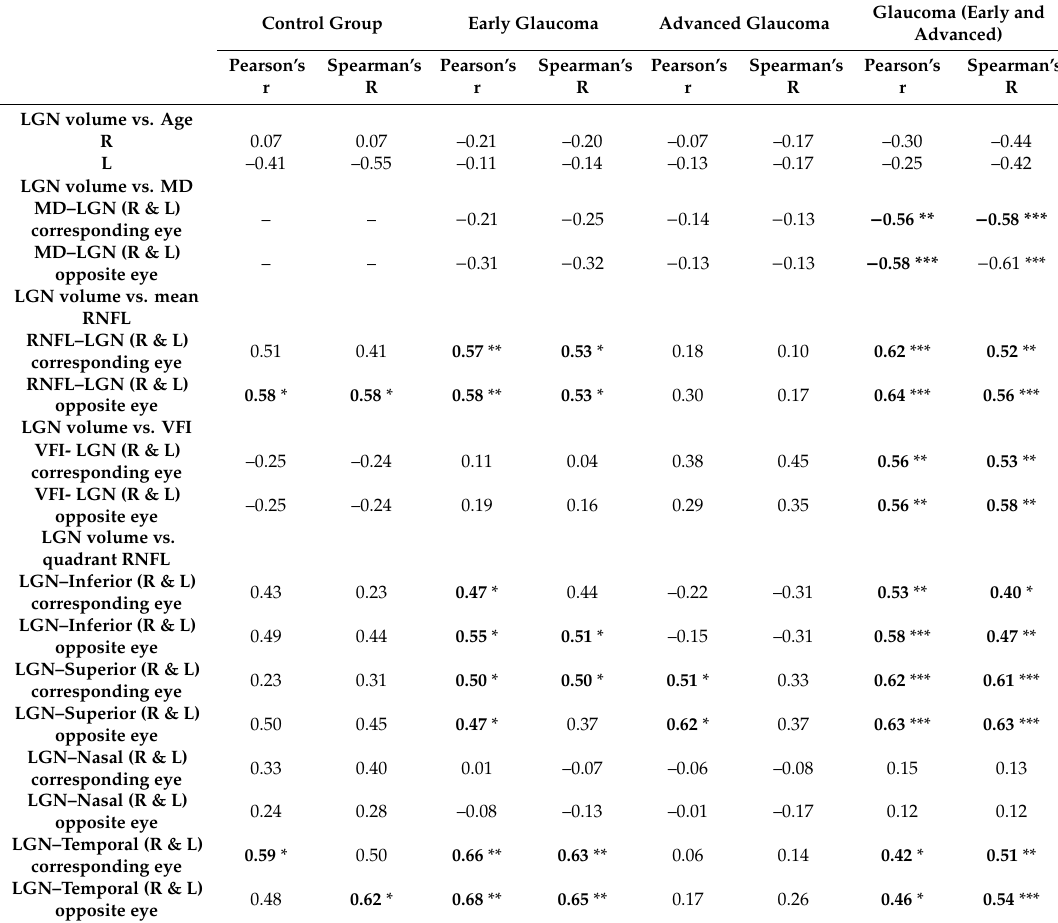
Table 5. Parametric (Pearson’s) and nonparametric (Spearman’s) correlations analysis between